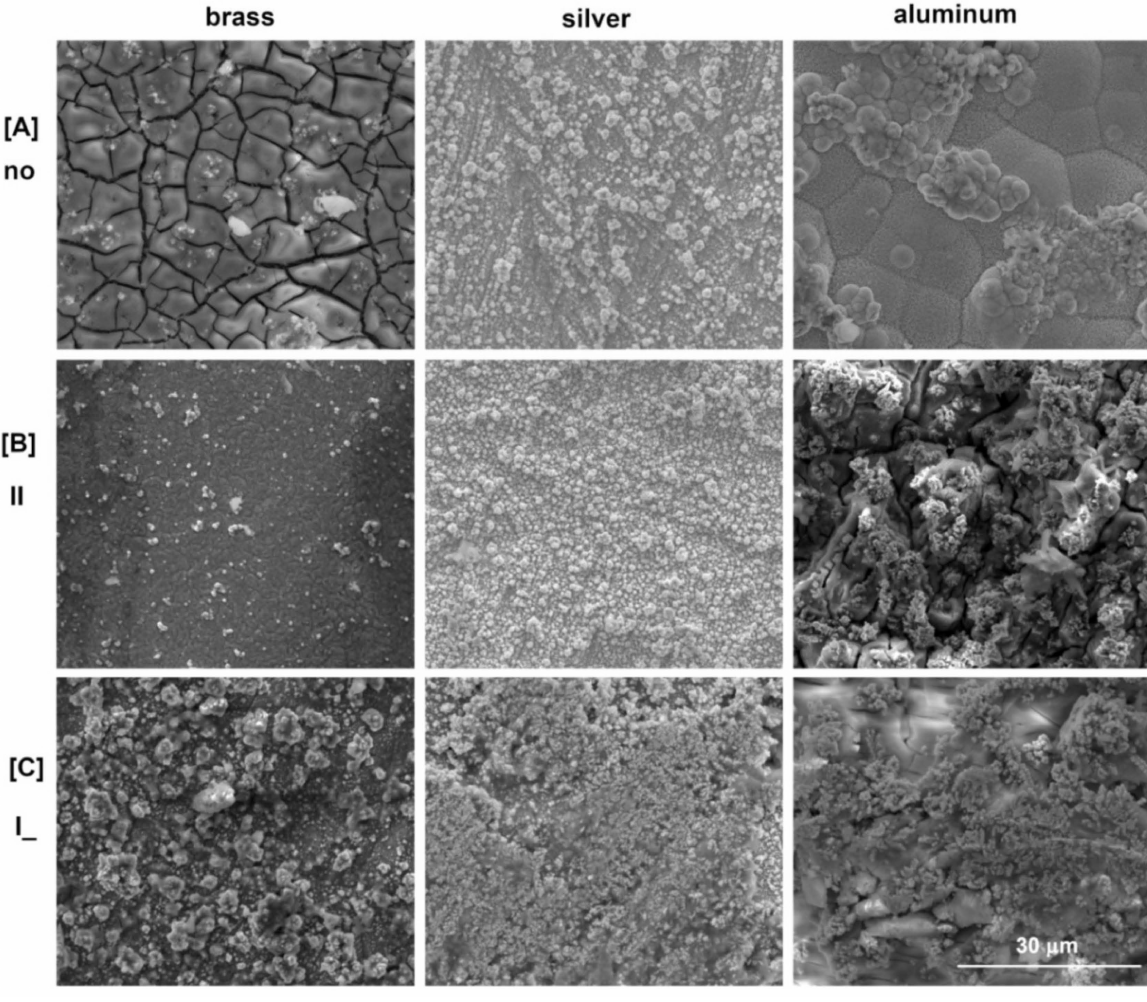
Figure 2. SEM images of the FeNi film on different substrates (magnification— × 5000): ( A ) without external magnetic field; both in presence of external magnetic field ( B ) II, ( C ) I_ orientation in respect to surface